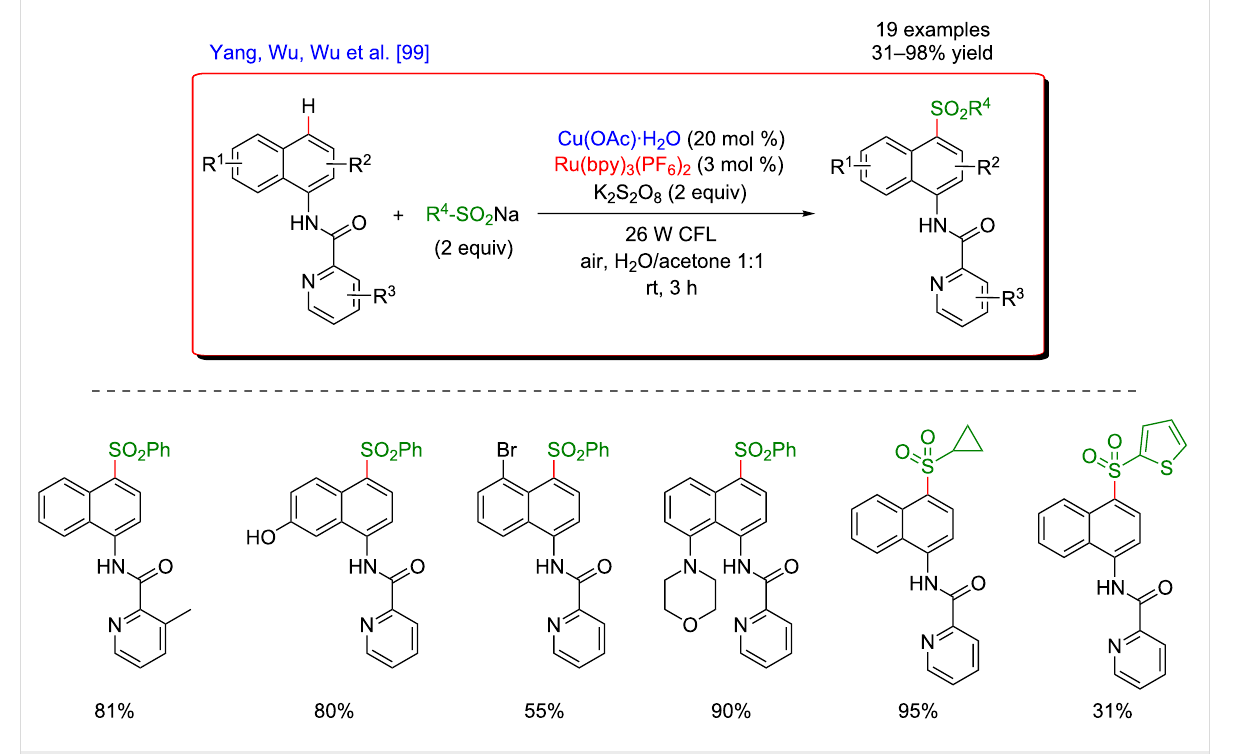
Figure 35: Sulfonylation of 1-naphthylamides via the dual C–H activation/photoredox catalysis.